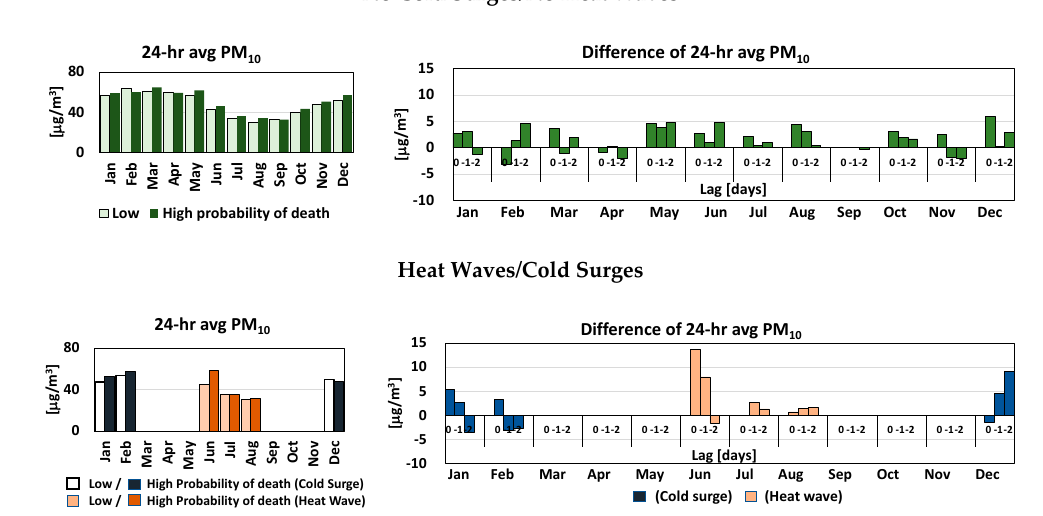
Figure 8. Comparison of monthly average PM 10 levels on days of high and low probability of death and the differences in